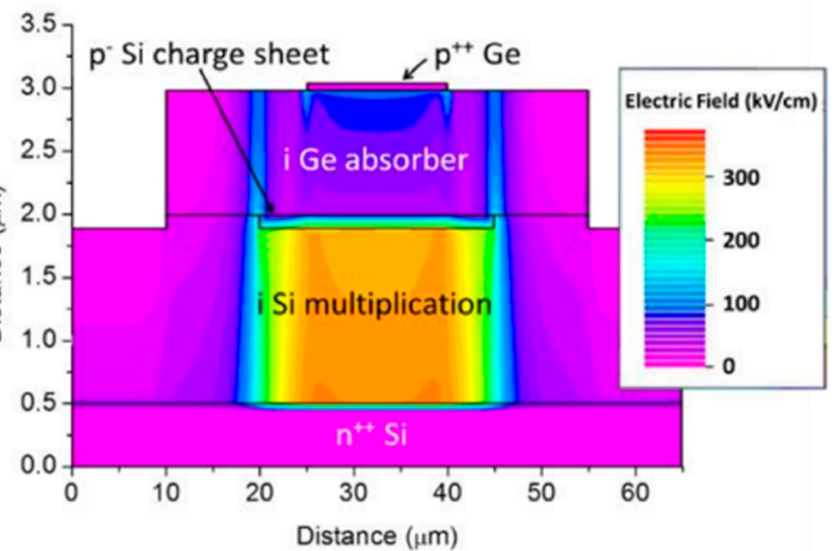
Figure 20. Electric field distribution for Ge/Si SPAD at 5% excess bias above the breakdown (the thickness of the Ge absorber is 1 μ m). Reproduced from [77], ROS Theses Repository, open access, 2019.